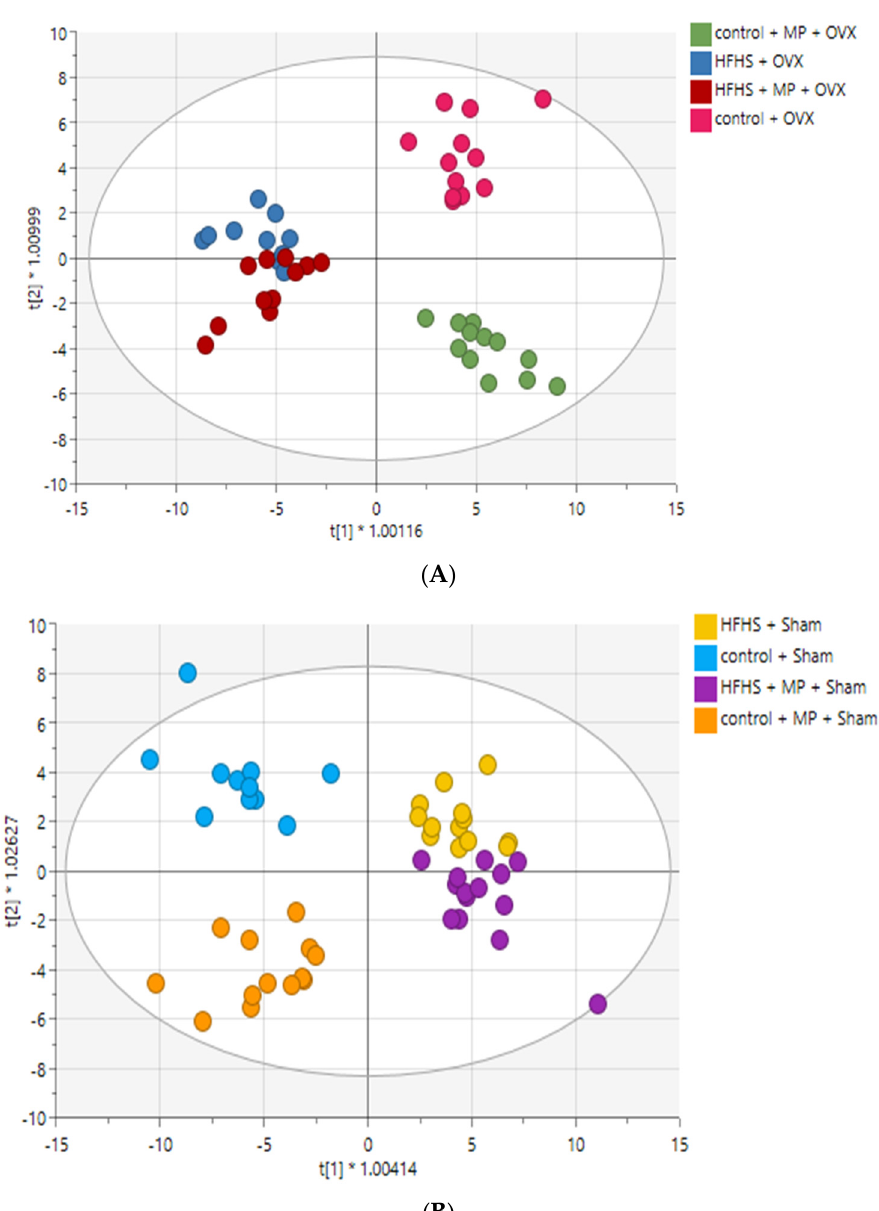
Figure 2. OPLS-DA analysis for lipidomic differences between diet groups showing good separation and robust modelling for sham rats and OVX rats. Each circle represents the lipid profile of a single rat. MP = greenshell mussel powder included in the diet. ( A ) OPLS-DA scoring plot showing discrimination between diets groups in OVX rats ( n = 45); R2X (cum) = 0.811, R2Y (cum) = 0.608, Q2 (cum) = 0.498. Cross-validated ANOVA p -value = 4.38326 × 10 -5 . ( B ) OPLS-DA scoring plot showing discrimination between diets groups in sham rats ( n = 51); R2X (cum) = 0.755, R2Y (cum) = 0.572, Q2 (cum) = 0.480. Cross-validated ANOVA p -value = 8.77889 × 10 -6 .